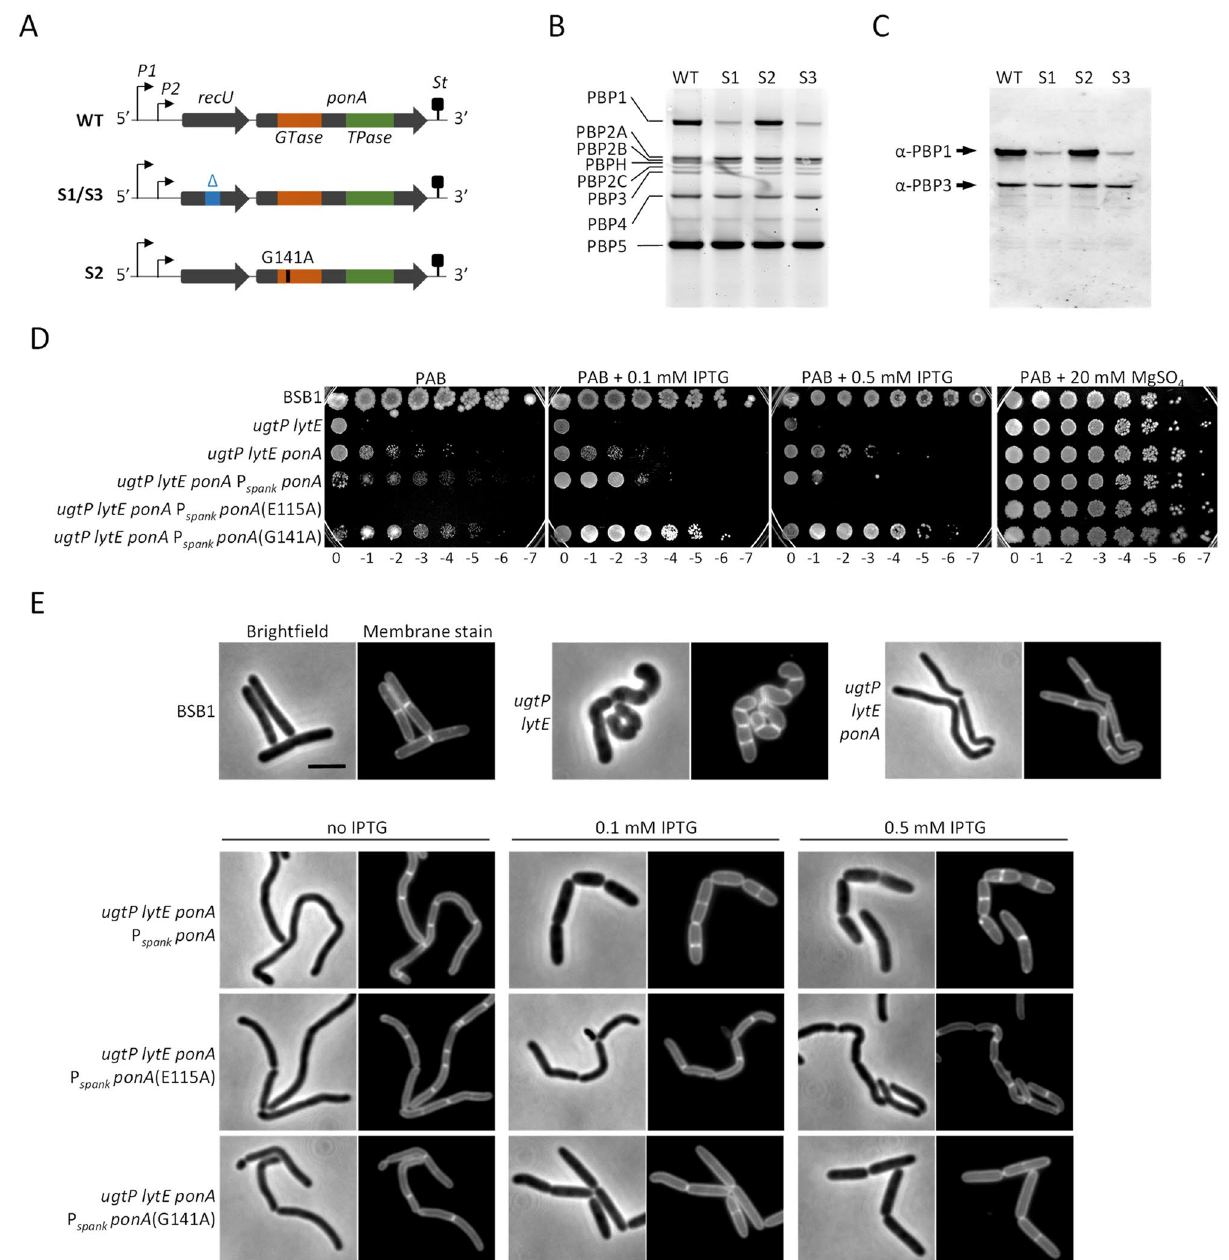
Figure 5. Changes in the PBP1 activity levels allowed growth of the ugtP lytE mutant. ( A ) The scheme represents the ponA operon. P1 and P2 represent the 2 promoters in the operon while St represents the stop codon. WT, the codon composition in wild type cells. S1 and S3 represent the two isolated suppressors with alterations in the recU sequence. S2 represents the third suppressor with a G141A point mutation in the PBP1 encoding gene ponA . ( B ) Bocillin binding assay shows smaller band corresponding to PBP1 for the suppressors S1 and S3 compared to wild type. Bands corresponding to other PBPs were comparable for the three suppressors and wild type cells. ( C ) Western blot against cell lysates from suppressor mutants and wild type cells using PBP1 polyclonal antibody and PBP3 polyclonal antibody as a loading control. The S1 and S3 samples showed smaller bands corresponding to the levels of PBP1 compared to the S2 mutant and WT cells suggesting lower levels of PBP1 in the cells. ( D ) Spot plate assay for mutants with deletions in the ugtP, lytE and ponA genes, and with ectopic expression of PBP1, PBP1 E115A or PBP1 G141A. UgtP lytE ponA triple mutants expressing low levels of PBP1 or PBP1 G141A, showed better phenotype compared to both BSB1 Δ ugtP Δ lytE and BSB1 Δ ugtP Δ lytE Δ ponA . ( E ) Fluorescence microscopy for the aforementioned mutants showed that BSB1 Δ ugtP Δ lytE Δ ponA recovered the rod-shape, however, cells were thin and bent. BSB1 Δ ugtP Δ lytE Δ ponA expressing low levels of PBP1 or PBP1 G141A, showed amelioration in the cell morphology where mutants looked mostly like the ugtP single mutant previously described as short cells (Supplementary Fig. S2). Scale bar 3